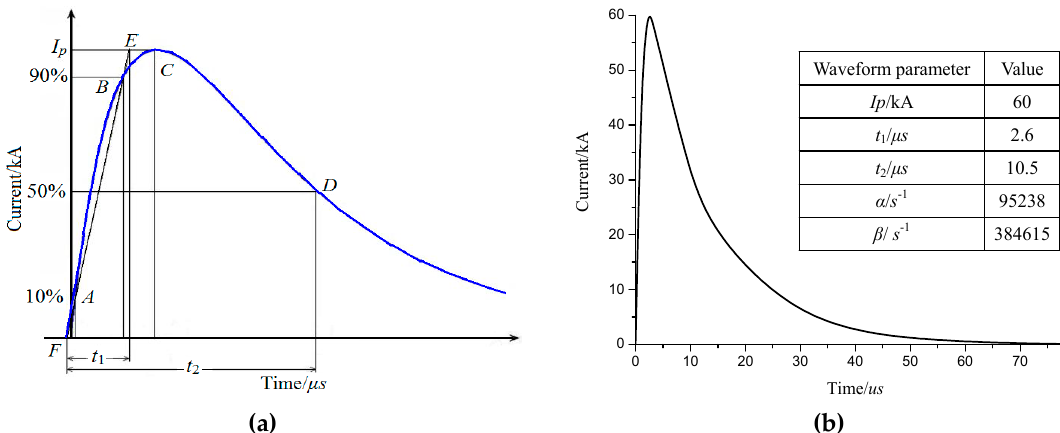
Figure 3. Double exponential impulse current waveform. ( a ) Relationship of t 1 / t 2 ; ( b ) waveform of 2.6/10.5 µs-0 kA.